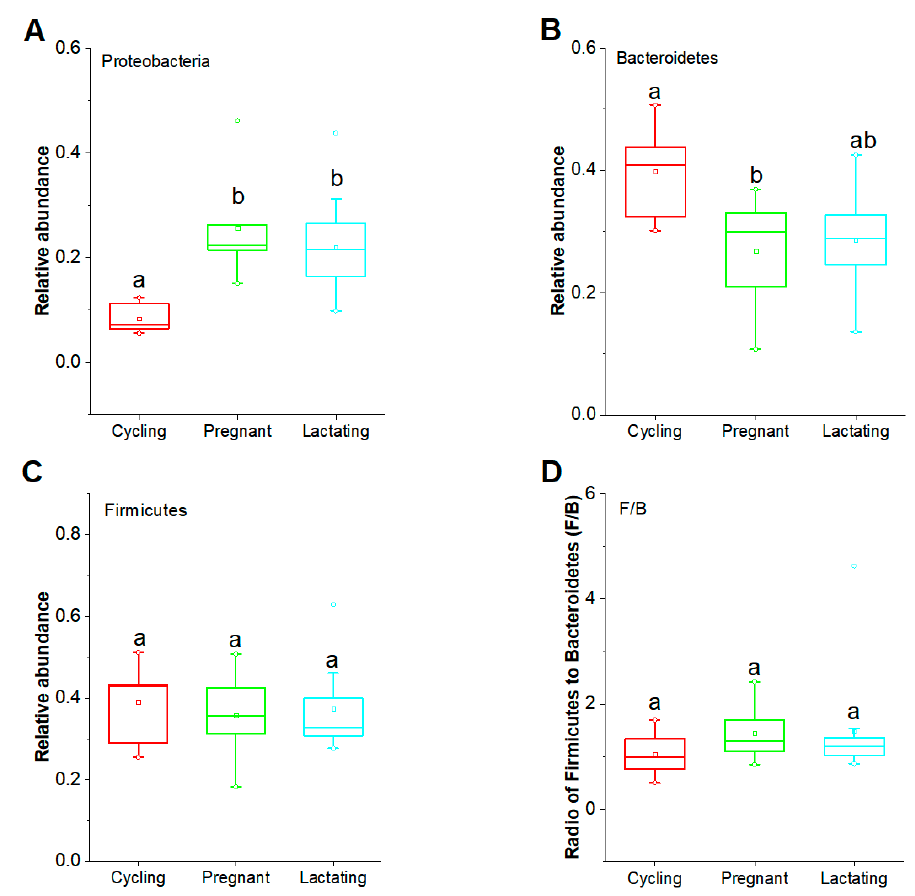
Figure 3. Variations of the dominant phyla across three reproductive states. ( A ): Comparison of the dominant phylum Proteobacteria. ( B ): Comparison of the dominant phylum Bacteroidetes. ( C ): Comparison of the dominant phylum Firmicutes. ( D ): Comparison of the ratio of F/B. Host hoc analyses in Linear Mixed Effects Models (LMMs) and p -values were corrected for multiple comparisons using the Bonferroni correction. Significance level was 0.05.